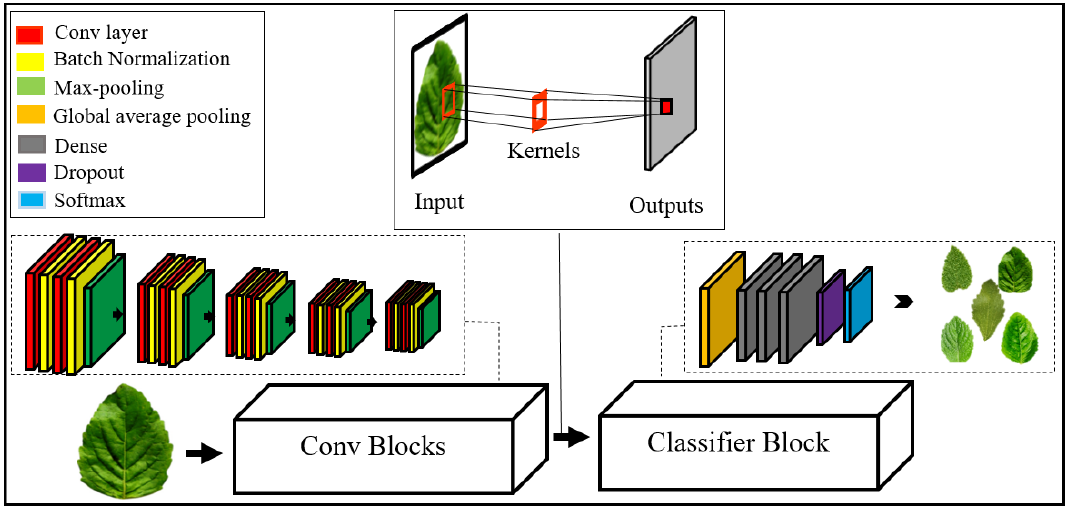
Figure 3. The architecture of the CNN model for image recognition.